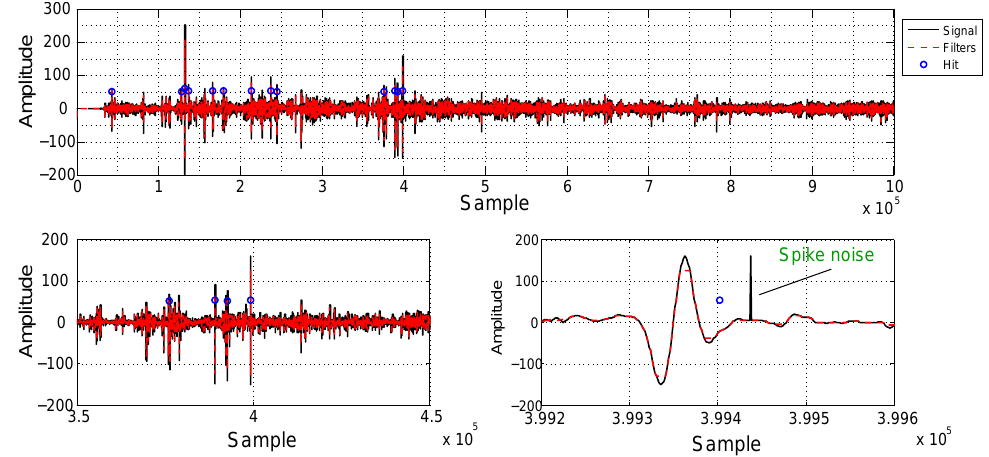
Figure 11. An example of the rail surface detection process. On the top, we can see a signal fragment of about 134 s long sampled at 7.5 kHz, where the horizontal axis indicates the sample number. The bottom plots are zooming versions of the signal. On the right plot, the blue circle indicates the location of the GPS